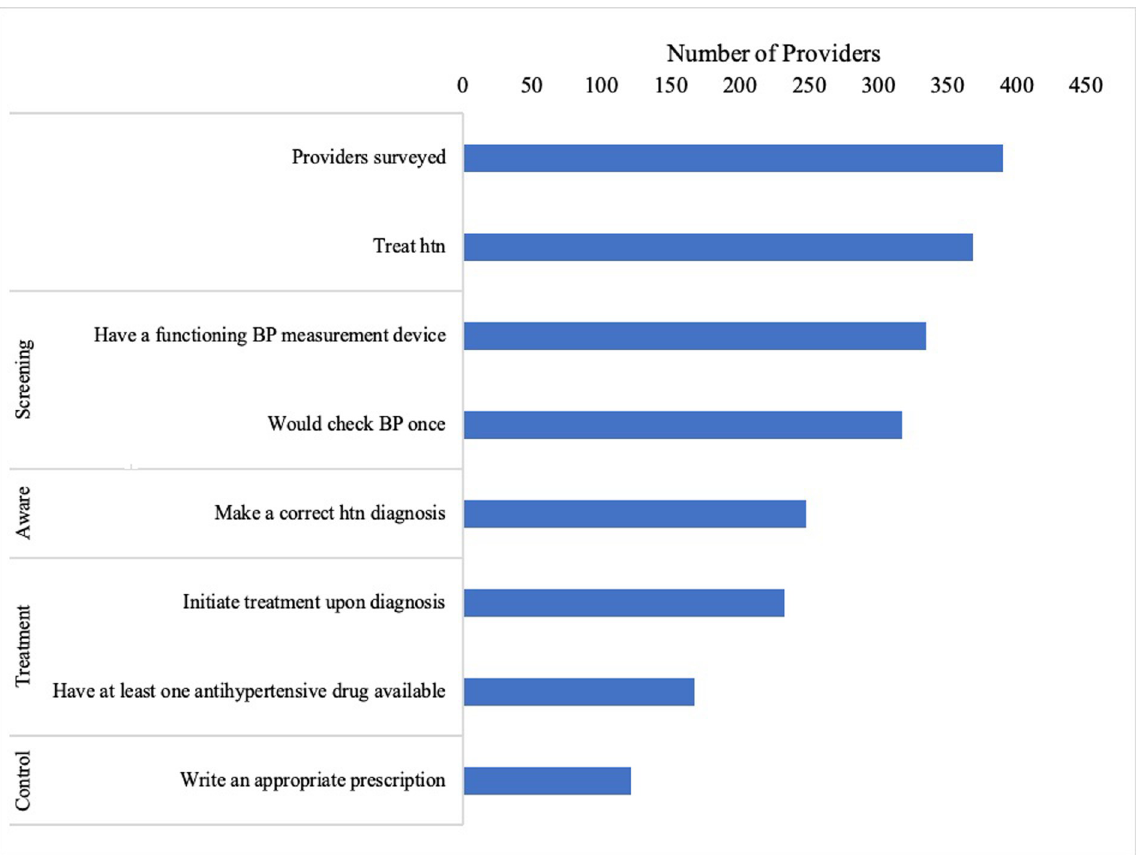
Fig 1. Provider cascade of quality hypertension care. BP = blood pressure; HTN = hypertension.